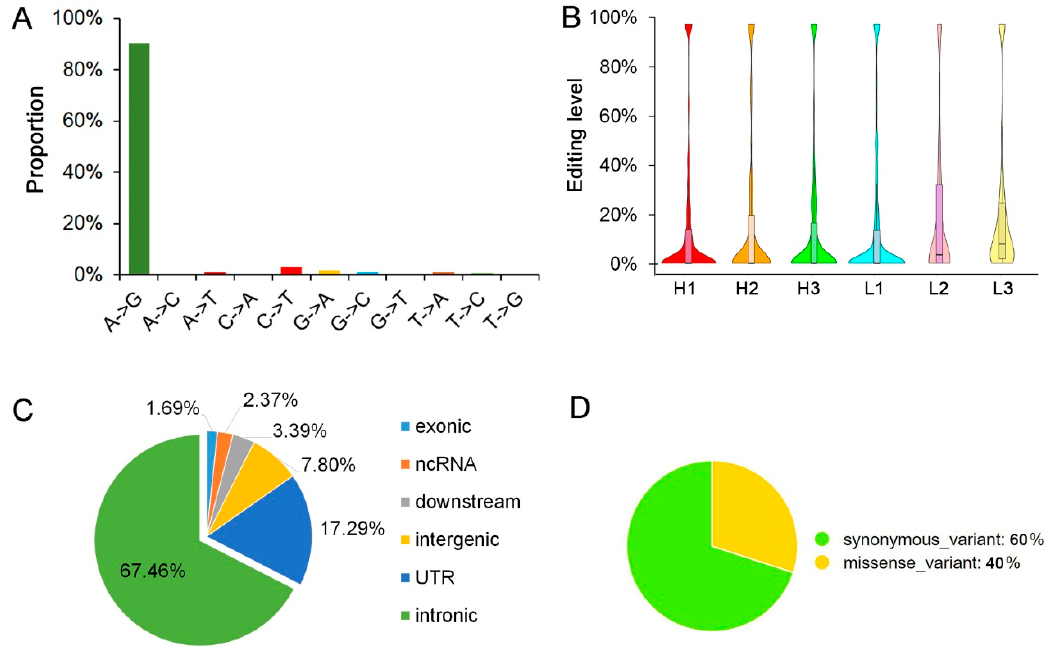
Figure 2. Landscape of the pig longissimus dorsi muscle editome. ( A ) Distribution statistic of detected RNA editing types. ( B ) The violin plot of editing levels of all of the editing sites. ( C ) Genomic features of RNA editing sites in or nearby genes. ( D ) Proportion of synonymous and missense exonic editing sites.